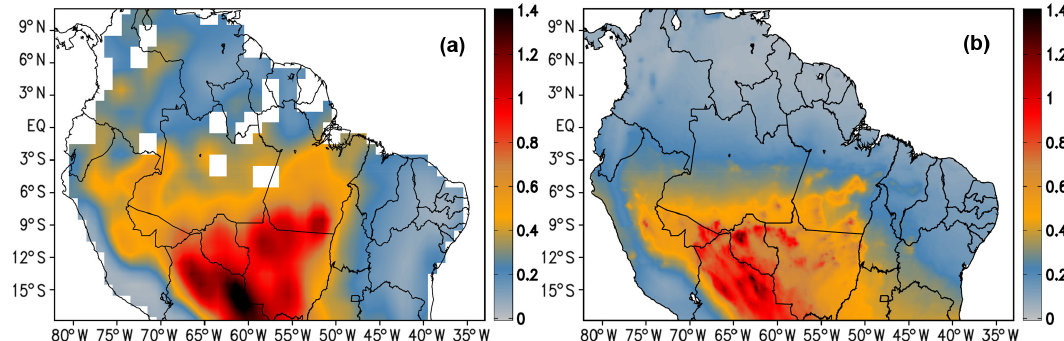
Figure 8. Monthly mean AOD at a 550nm wavelength for September 2010 from the (a) MODIS Aqua retrieval and (b) from the model as simulated in the DIR+DIF